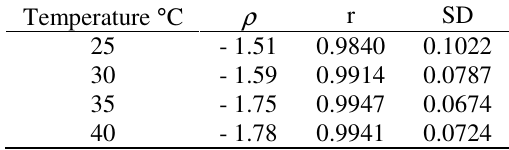
Table 6. ρ Values obtained from Hammett